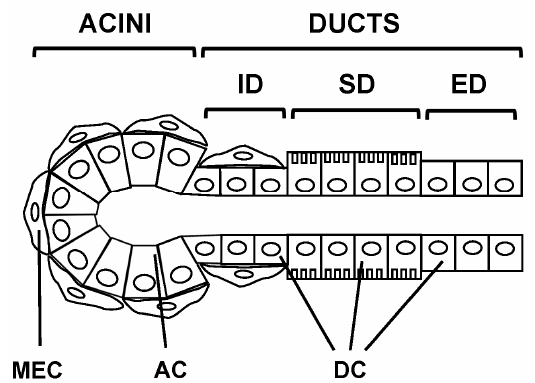
Figure 1. Morphology of salivary glands. Salivary glands are made of three epithelial cell types: acinar (AC), ductal (DC) and myoepithelial cells (MEC). Acinar cells organized into acini connected to a network of ducts classified into intercalated (ID), striated (SD) and excretory ducts (ED).